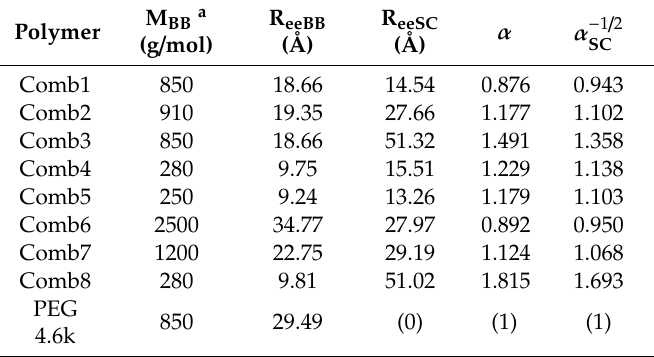
Table 2. The relaxed end-to-end distances and stretching parameters describing the confinement of the backbone and side chains. In the two rightmost columns, stretching is indicated by values larger than 1. Values smaller than 1 indicate no stretching and could be replaced by